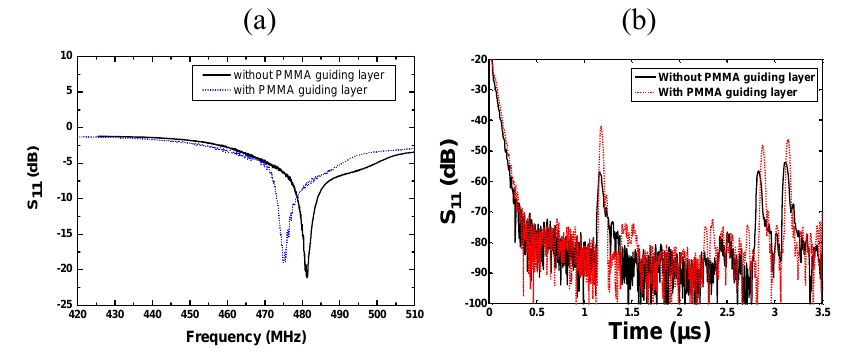
Figure 9. Frequency shift (a) and amplitude change (b) of the SH SAW reflective delay line coated with PMMA guiding layer.